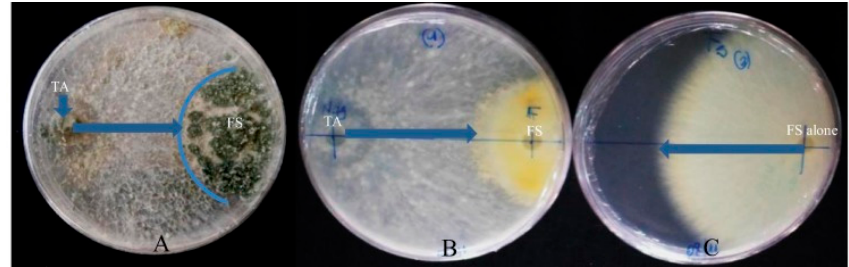
Figure 4. Antagonistic e ff ects of Trichoderma atroviridae from T.catappa on F. solani, the causative agent of commom bean rot root. Diagonally opposed inocula were grown to assess the biological control potential of Trichoderma spp. over F. solani . Results indicated that the BCA grew faster and sporulated on the pathogen and, consequently, restricted its growth compared to the negative control